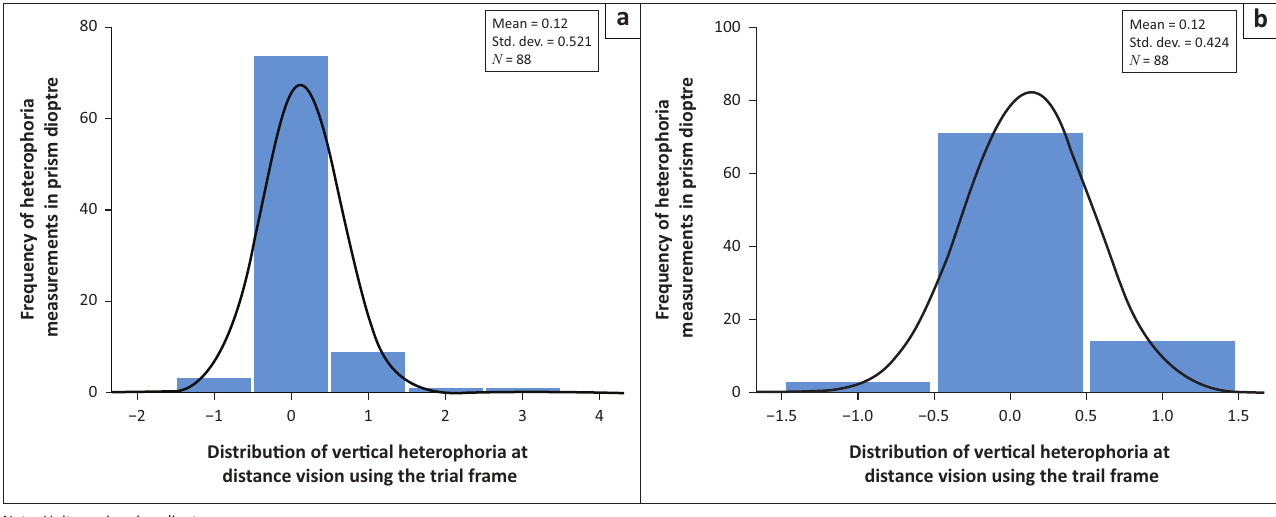
Distribu(cid:31)on of horizontal heterophoria at near vision using the trial frame a Mean = 0.12 Std. dev. =